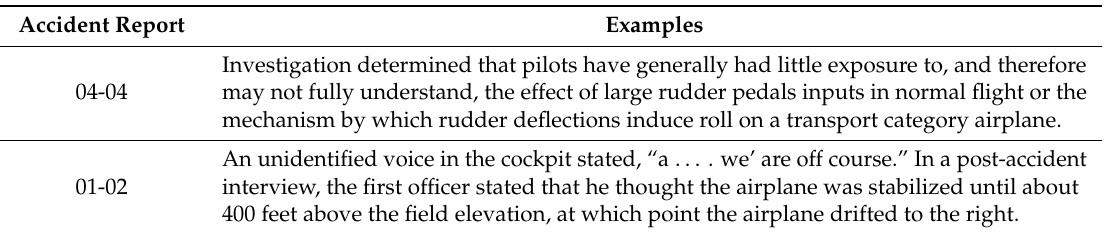
Table 8. Examples of Loss of Situational